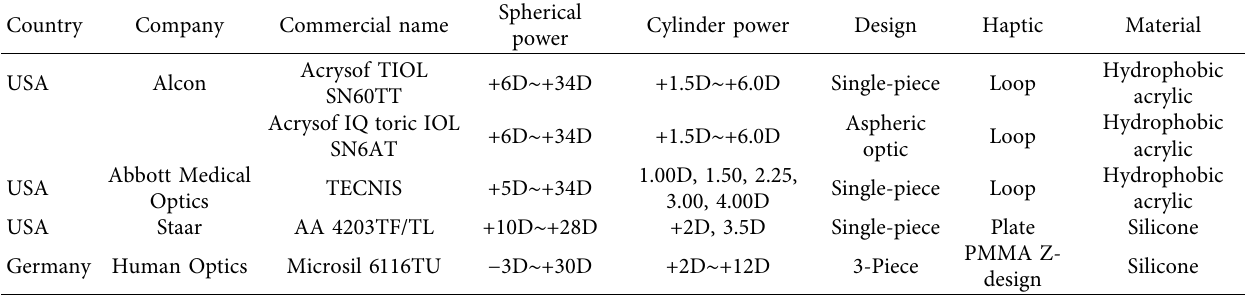
Table 1: Characteristics of toric IOLs included in the meta-analysis.